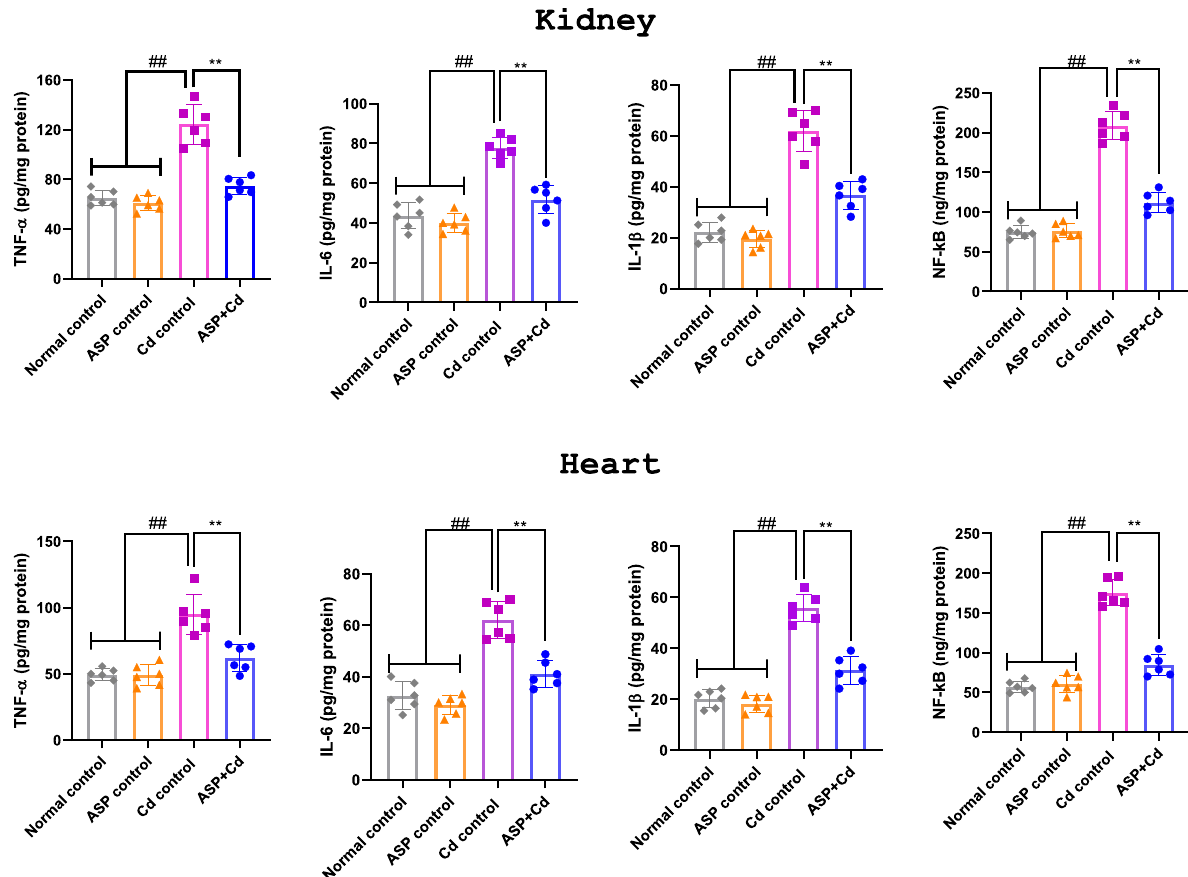
Figure 3. Effects of asperuloside on kidney and heart TNF-α, IL-6, IL-1β and NF-кB of cadmium administered rats. Histograms represent the mean ± SD (n = 6). For all panels: ## p < 0.05 compared to normal and ASP control groups; ** p < 0.05 compared to Cd control group